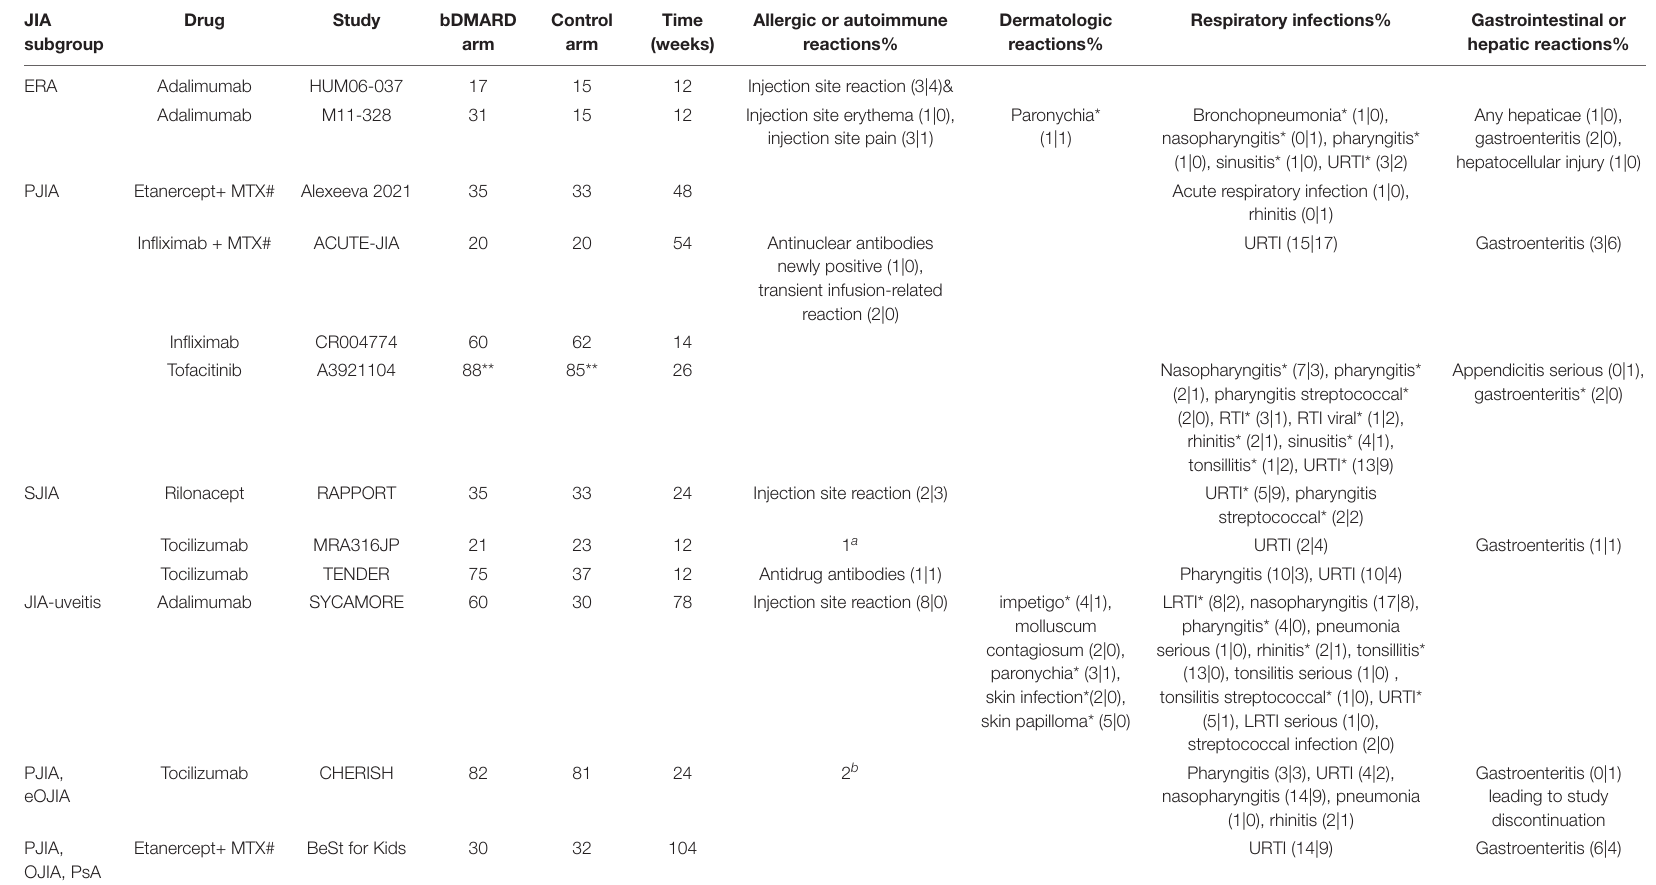
TABLE 3 | Overview of adverse events of interest in the 12 JIA RCTs that reported Pedi ACR 30/50/70 data at month 3 (i.e., weeks 12–14). JIA